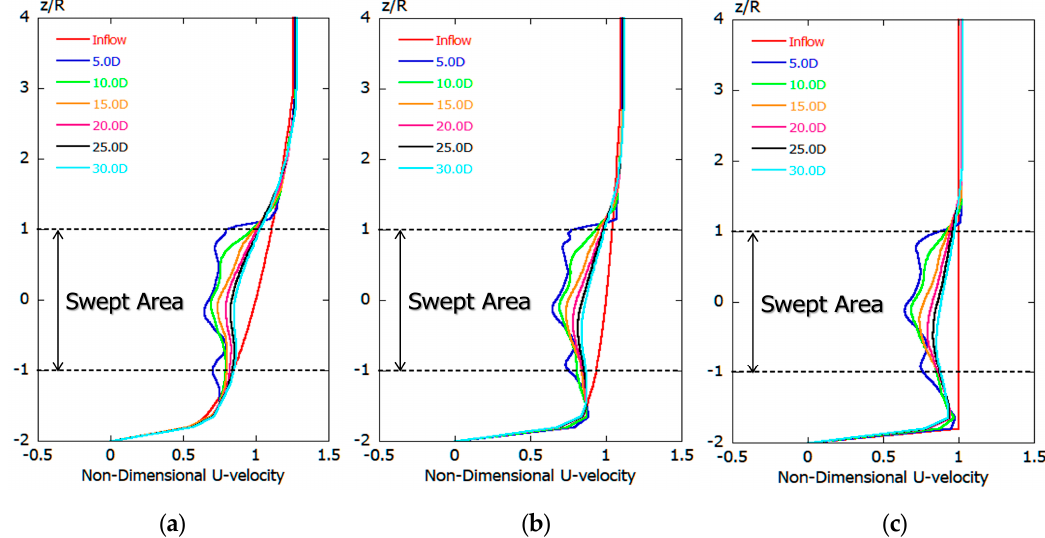
Figure A1. Comparison of vertical distribution of time-averaged U-velocity: ( a ) N = 4, ( b ) N = 10, and ( c ) uniform flow.